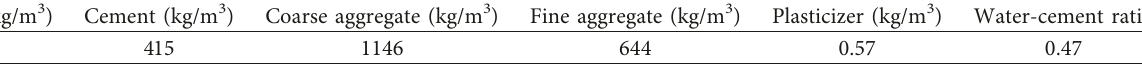
Table 1: Mixture proportion of concrete.